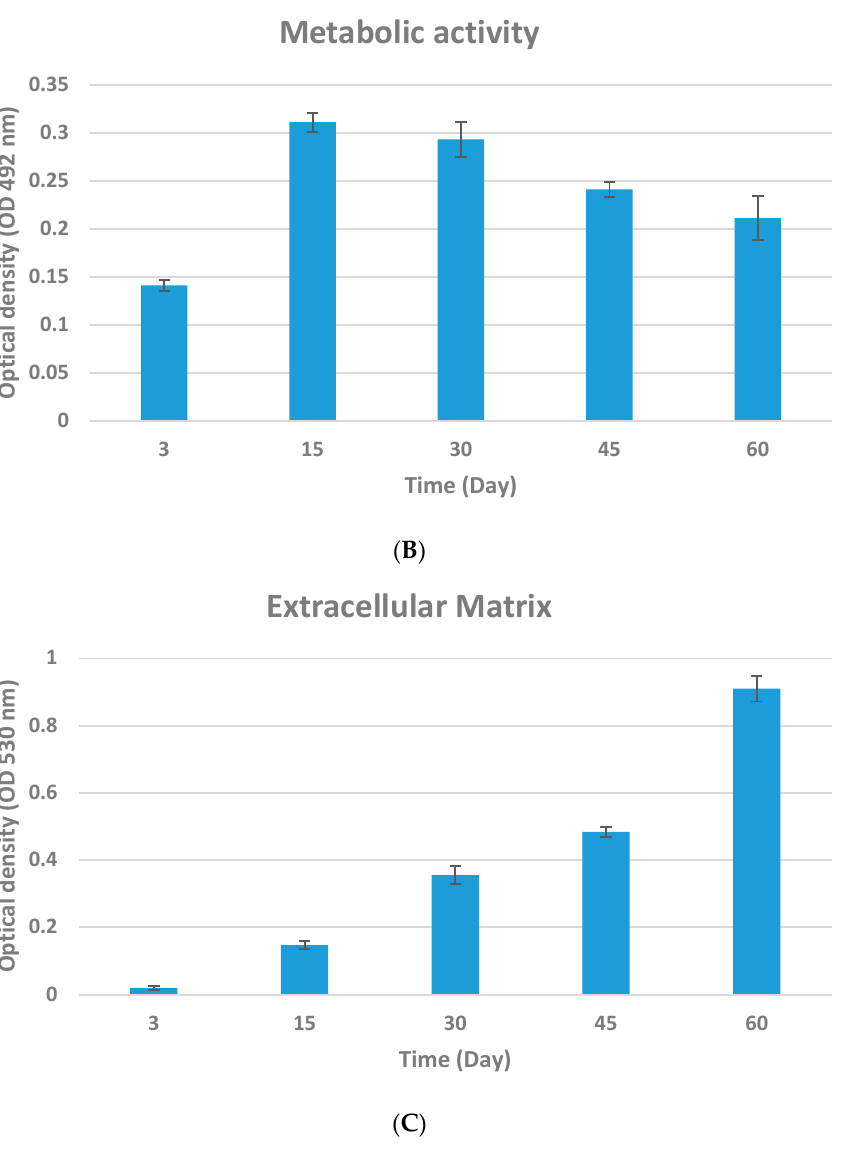
Figure 3. Biofilm formation by S. boulardii CNCM I-745 on glass surface during beer storage for 3, 15, 30, 45, and 60 days at 20 °C. After each time point, the 8-well glass slides were processed to detect ( A ) Yeast biomass by incorporation of crystal violet in methanol-fixed biofilms (at 590 nm), ( B ) metabolic activity by reduction of XTT in formazan by viable cells (492 nm), and ( C ) extracellular matrix by staining with safranin (530 nm). The results are presented as the means of three independent replicates ± SDs.